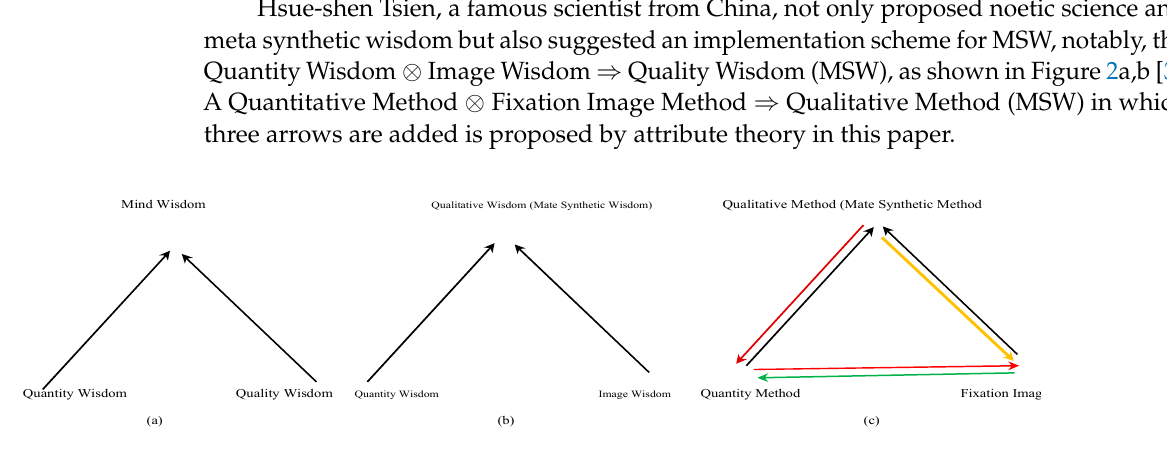
Figure 2. ( a ) Quantity Wisdom ⊗ Quality Wisdom ⇒ Mind Wisdom (by Dai Ruwei); ( b ) Quantity Wisdom ⊗ Image Wisdom ⇒ Qualitative Wisdom (Mate Synthetic Wisdom) (by Hsue-shen Tsien); ( c ) Three arrows added Quantity Method ⊗ Fixation Image ⇒ Qualitative Method (Mate Synthetic Method ( c ) (by Jiali Feng).